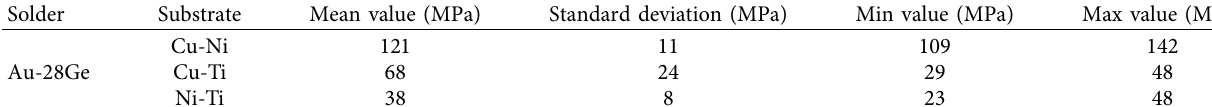
Table 1: Shear strength of Au-28Ge solder joints on different substrates [50].